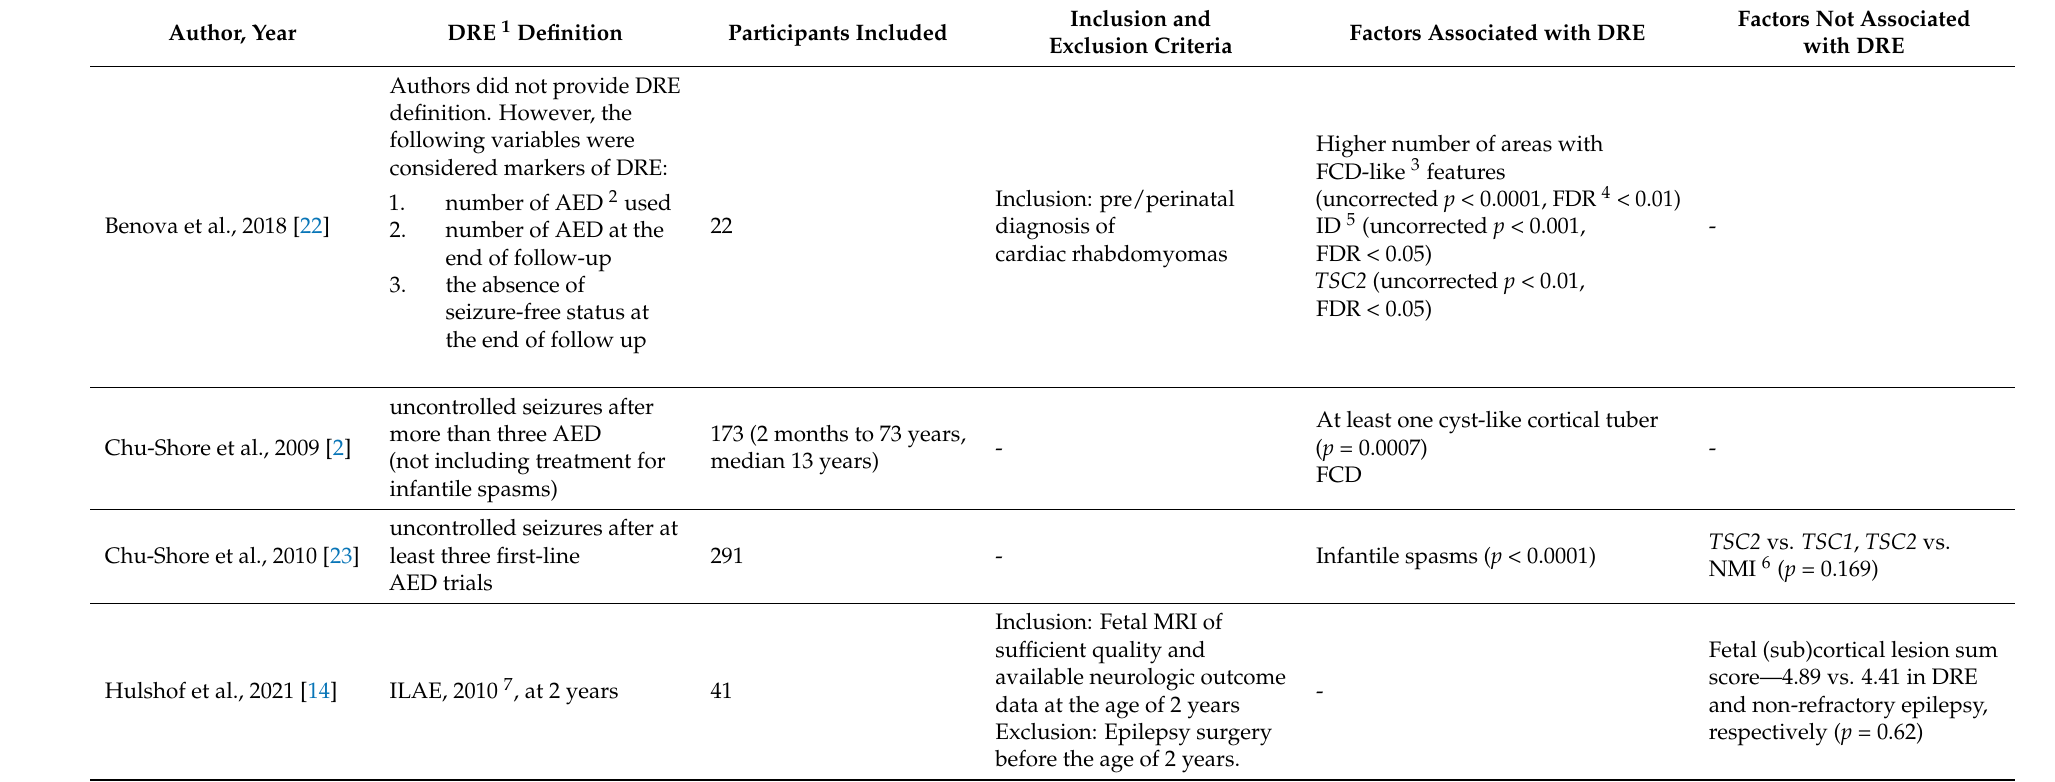
Table 1. Characteristics of the cohorts in the included